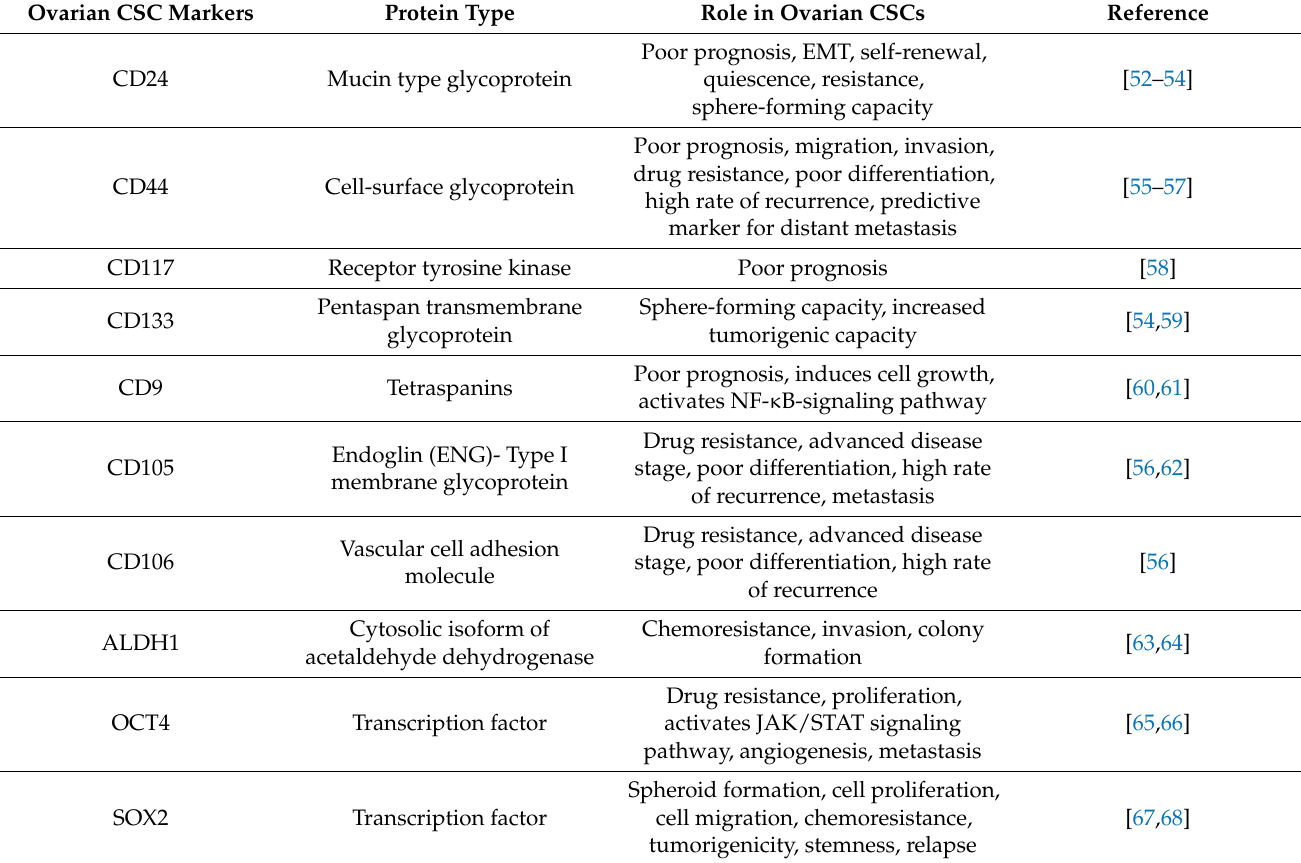
Table 2. Existing markers of ovarian cancer stem cell and their role in disease progression. Ovarian CSC